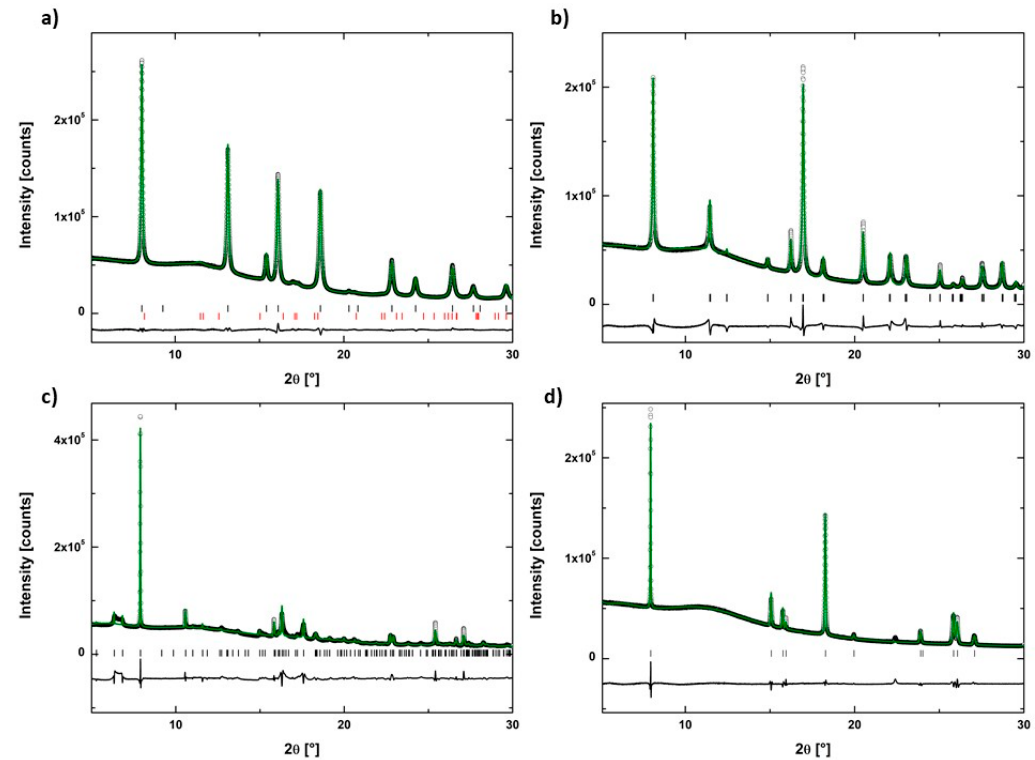
Figure 6. Rietveld refinements of the SR-PXD data for ( a ) Mg 0.5 Mn 0.5 (NH 3 ) 6 Cl 2 at RT (R wp = 1.48 %), ( b ) Mg 0.5 Mn 0.5 (NH 3 ) 2 Cl 2 at 214 °C (R wp = 3.17 %), ( c ) Mg 0.5 Mn 0.5 (NH 3 )Cl 2 at 280 °C (R wp = 5.02 %), and ( d ) Mg 0.5 Mn 0.5 Cl 2 at 402 °C (R wp = 3.19 %); showing the experimental (black circles), calculated (solid green line) and the difference plot (solid black line). The vertical ticks mark the Bragg peak positions for the corresponding compounds. λ =0.82646 Å. In (a) vertical ticks mark Mg 0.5 Mn 0.5 (NH 3 ) 6 Cl 2 (97.6(6) wt%, black) and Mg 0.5 Mn 0.5 (NH 3 ) 2 Cl 2 (2.4(5) wt%, red).